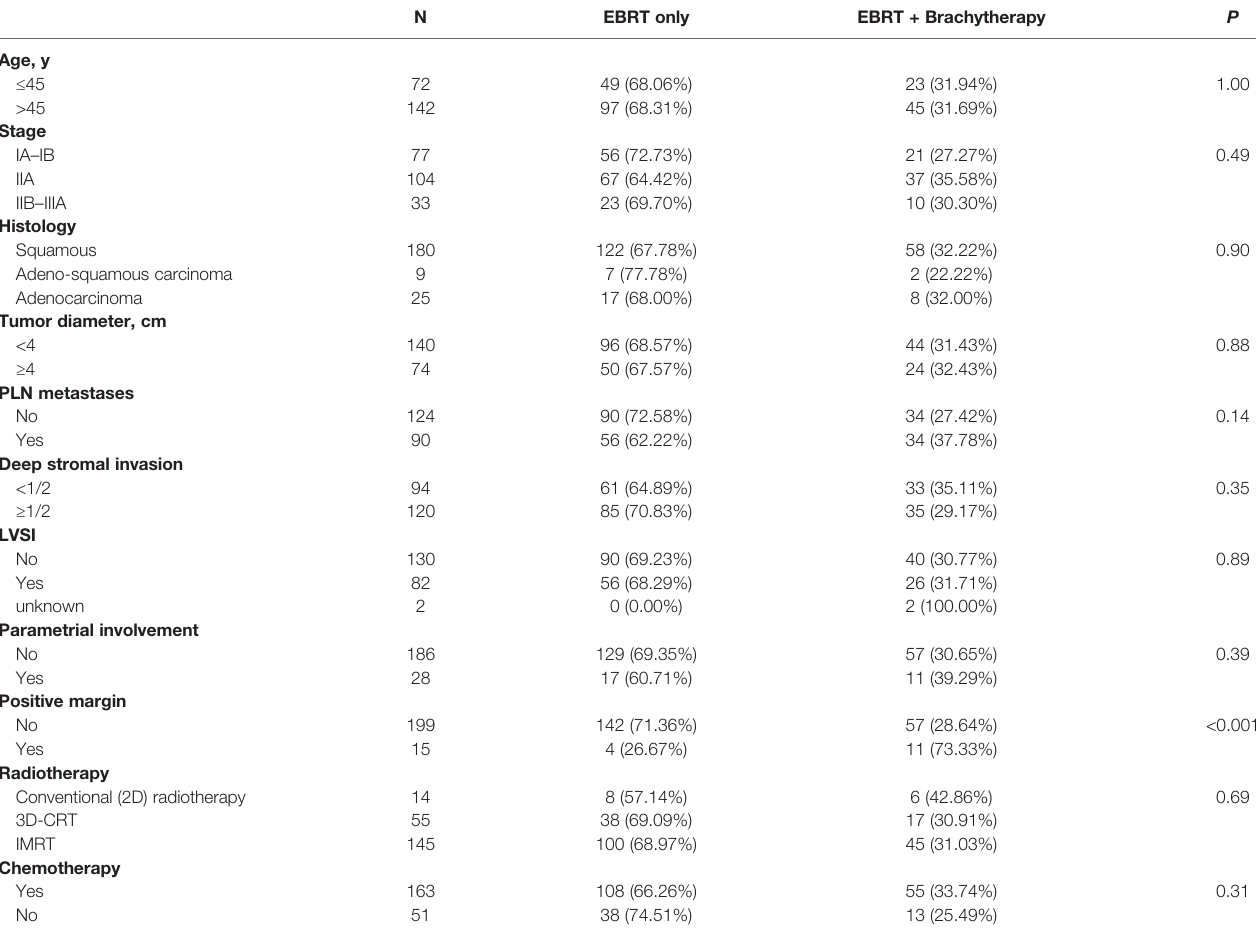
TABLE 1 | Patients ’ Clinical and Pathological Characteristics.